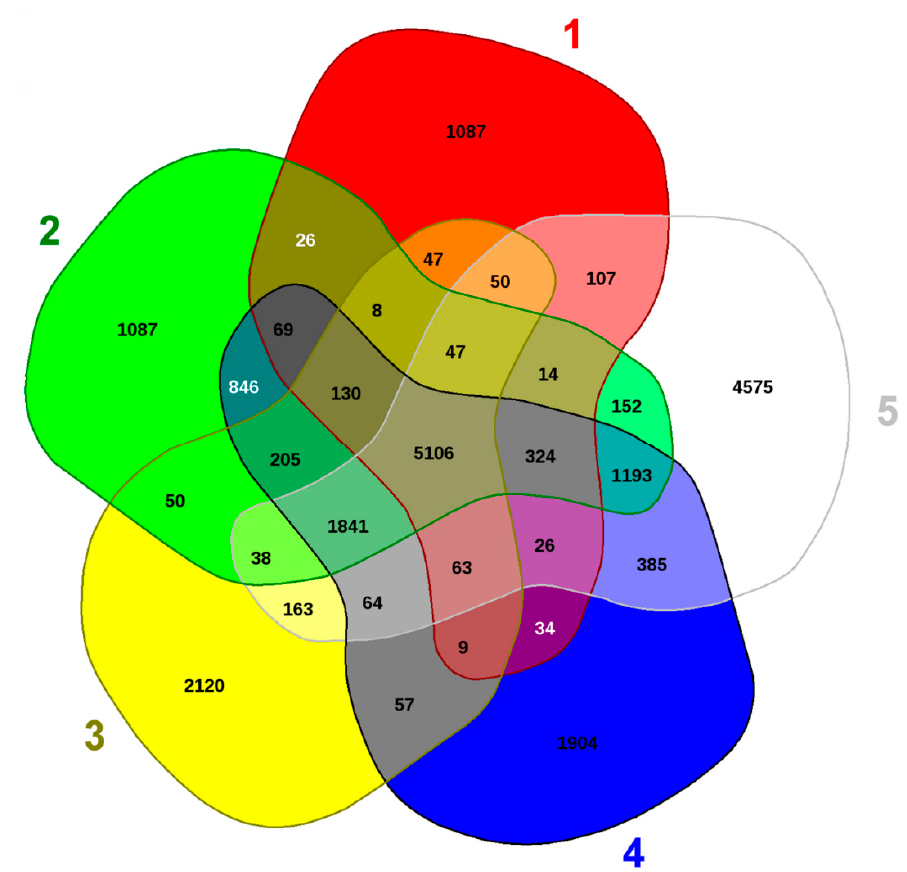
Figure 9. Whole genome sequence-based Venn diagram generated between Penicillium sp. strain MT2 with four closest taxonomic relatives. Venn diagram sectors belong to 1, Penicillium decumbens strain IBT; 2, Penicillium janthinellum strain NCIMI366; 3, Penicillium oxalicum ; 4, Penicillium sp. strain MT2; and 5, Penicillium subrubescens strain CBS, respectively. The number of singleton genes appear in red, green, yellow, blue, and white areas for strains 1–5 listed above, along with their core genomes (centered gray area). Table S1: Shotgun based sequence reads obtained from the SRS soils and DC / MT culture conditions. Table S2: Comparative genomics based identification of environmentally relevant functions in strain MT2. Figure S1: Bacterial core microbiome identified at the genus level using shotgun metagenomic libraries from the SRS soils. Figure S2: Univariate statistical comparisons and di ff erential count analysis of Burkholderia spp., in DC / MT relative to soil. Figure S3: Archaeal relative abundance analysis shown at the phyla and genus levels from the soils and DC / MT chambers. Figure S4: Archaeal core microbiome and dendrogram analysis identified at the genus level using shotgun metagenomic libraries from the SRS soils. Figure S5: Heatmap, PCA and dendrogram analysis of gene functions identified across di ff erent generations of DC / MT relative to soil. Figure S6: 16S / 18S gene based phylogenetic tree of the isolated bacterial and fungal strains. Figure S7: Whole genome sequence based synteny dot